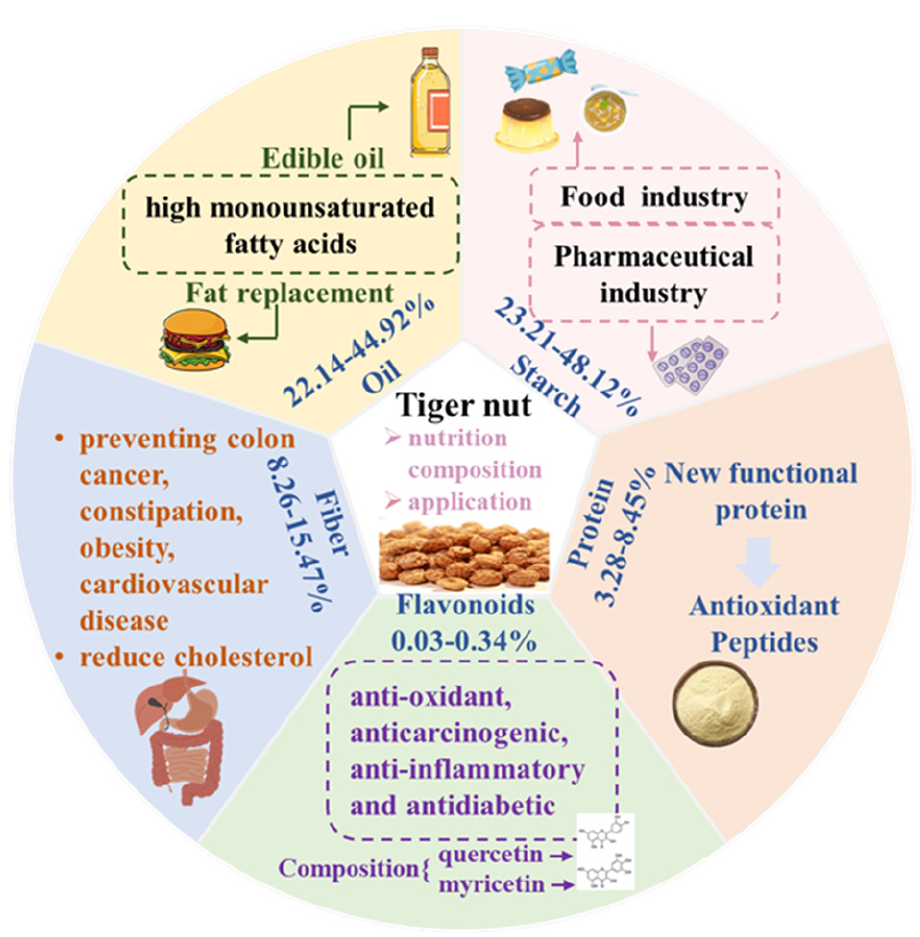
Figure 1. The main nutrition composition and nutrient-based applications of tiger nut.